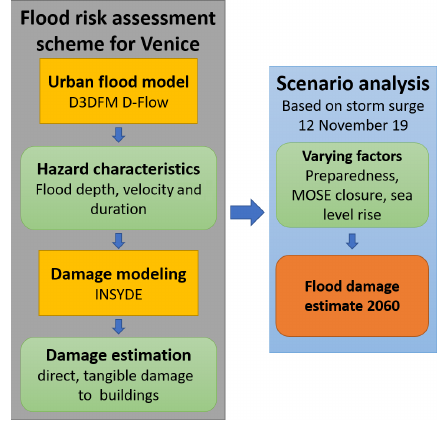
Figure 1. Risk assessment framework.